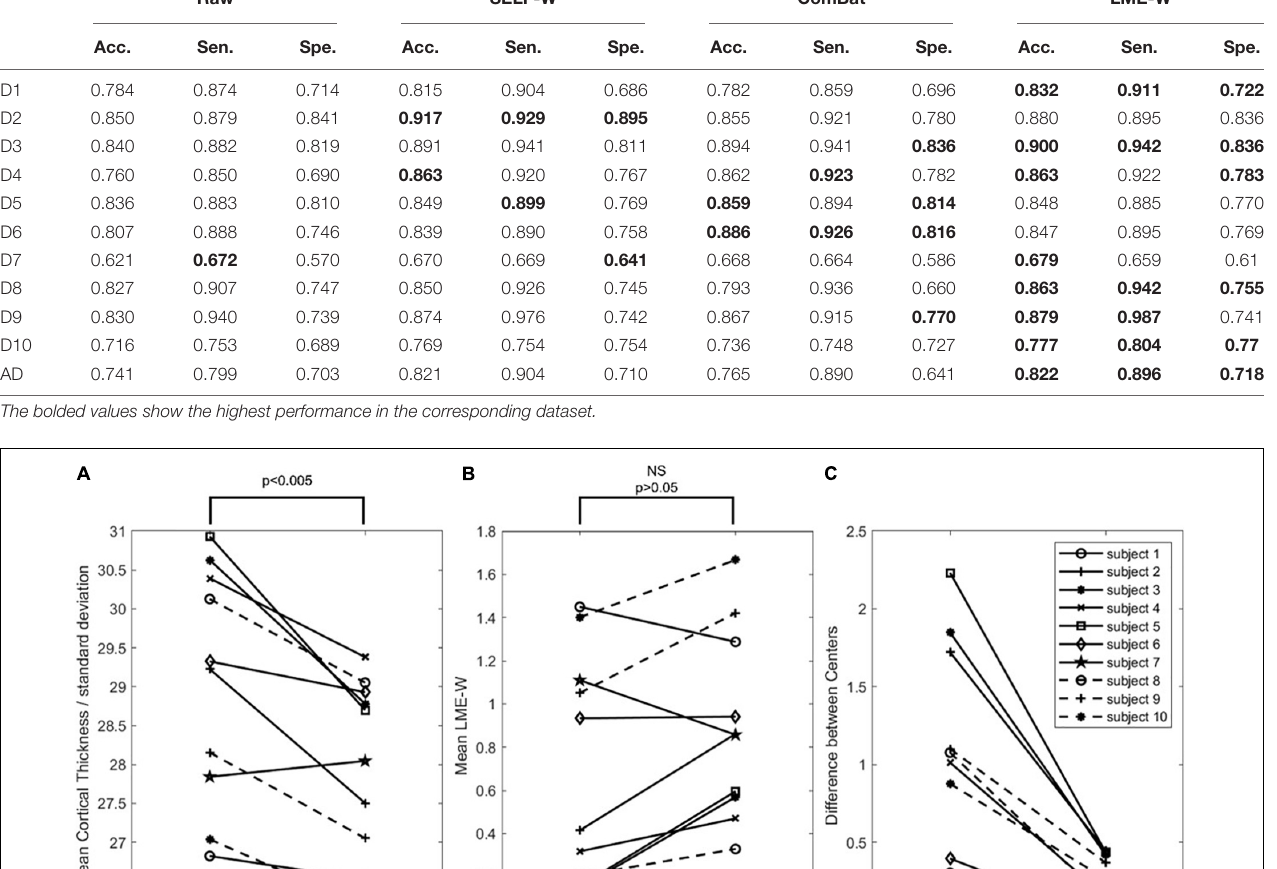
TABLE 3 | Cognitive normal-vs.-patient prediction results before/after normalization. Raw SELF-W ComBat LME-W Acc. Sen. Spe. Acc. Sen. Spe. Acc. Sen. Spe. Acc. Sen. Spe.